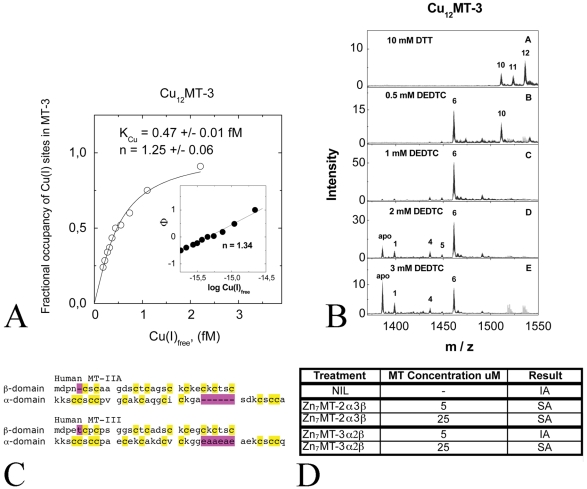
Using ESI-MS, we determined that the Cu(I)-binding affinity of MT-3 (KCu) is equal to 0.47±0.01 fM)(A).To investigate the binding affinities of the individual copper-thiolate clusters of MT-3, we exposed Cu12MT-3 to the high affinity Cu(I)-binding chelator DETC (B). At 0.5 mM concentration DETC, Cu12MT-3 converted to a predominant Cu6MT-3 form, which could be further demetallated to apo-MT-3 at 3 mM DETC (B). Human MT-3 shares approximately 60% amino acid sequence homology with human MT-2A (C). Conserved cysteines are highlighted in yellow, and amino acid insertions indicated in purple. Zn7MT-3β2α was able to prevent formation of SDS-insoluble Aβ1–40 aggregates (IA), while Zn7MT-2β3α could only prevent insoluble aggregate formation at a concentration of 25µM (D).